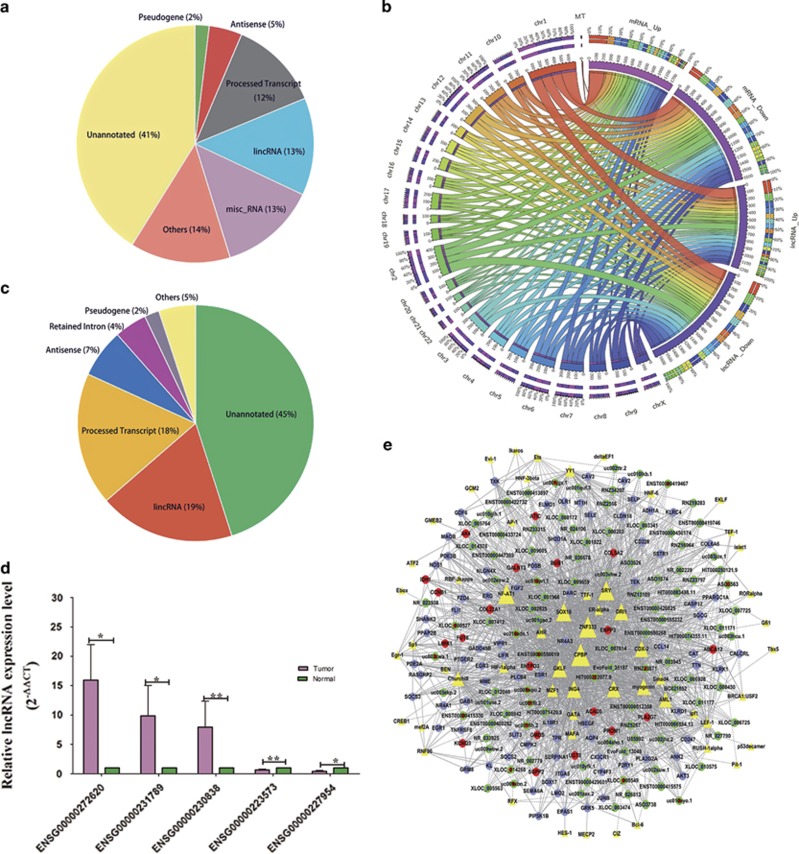
Expression profiling of lncRNAs and protein-coding genes via microarray analysis. (a) Biotypes of lncRNAs profiled. (b) Differentially expressed lncRNAs and protein-coding genes presented as a Circos plot. (c) Biotypes of differentially expressed lncRNAs. (d) The microarray results of five differentially expressed lncRNAs were selected for validation in 20 LUAD patients. ENSG00000272620: AFAP1-AS1; ENSG00000231789: PIK3CD-AS2; ENSG00000230838: AC093850.2; ENSG00000223573: TINCR; ENSG00000227954: TARID. *P<0.05, **P<0.01. (e) TF–lncRNA–protein-coding gene network; yellow: TFs; red: upregulated protein-coding genes; purple: downregulated protein-coding genes; green and red: upregulated lncRNAs; green and purple: downregulated lncRNAs. Error bars indicate means±S.E.M.